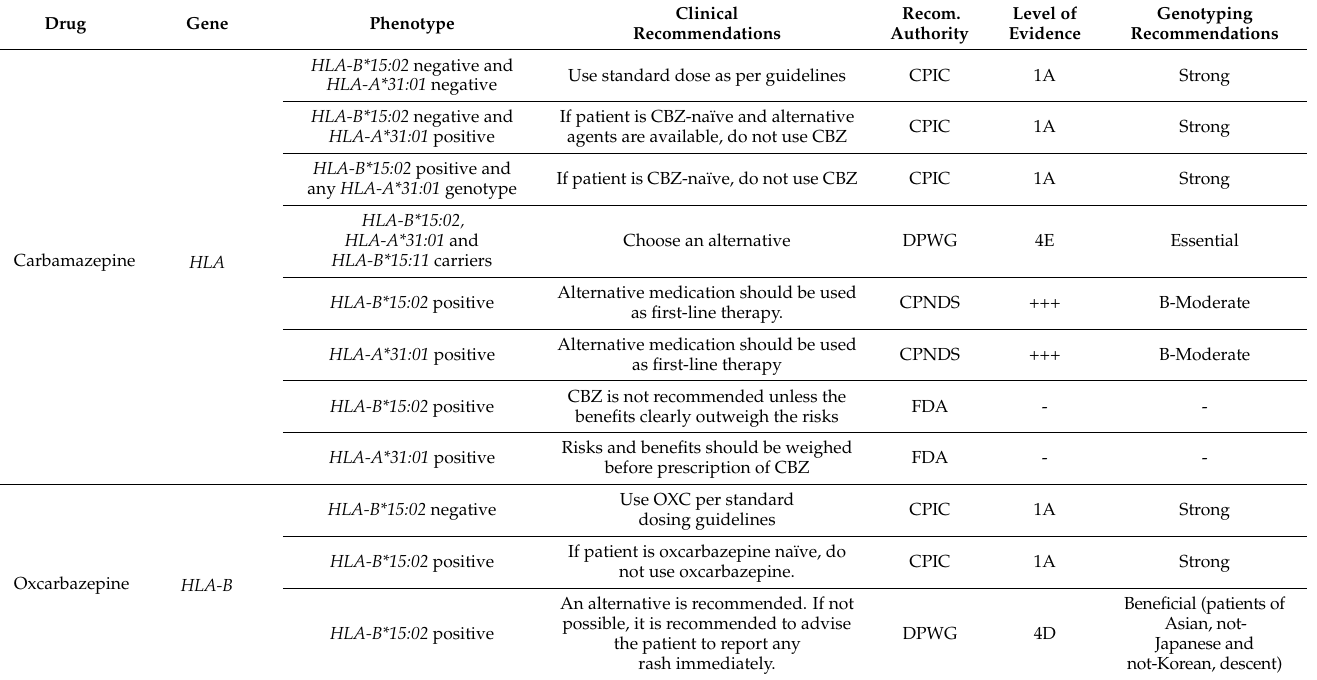
Table 5. Comparison of HLA genotyping and clinical recommendations provided by different international pharmacogenet- ics working bodies and drug regulatory